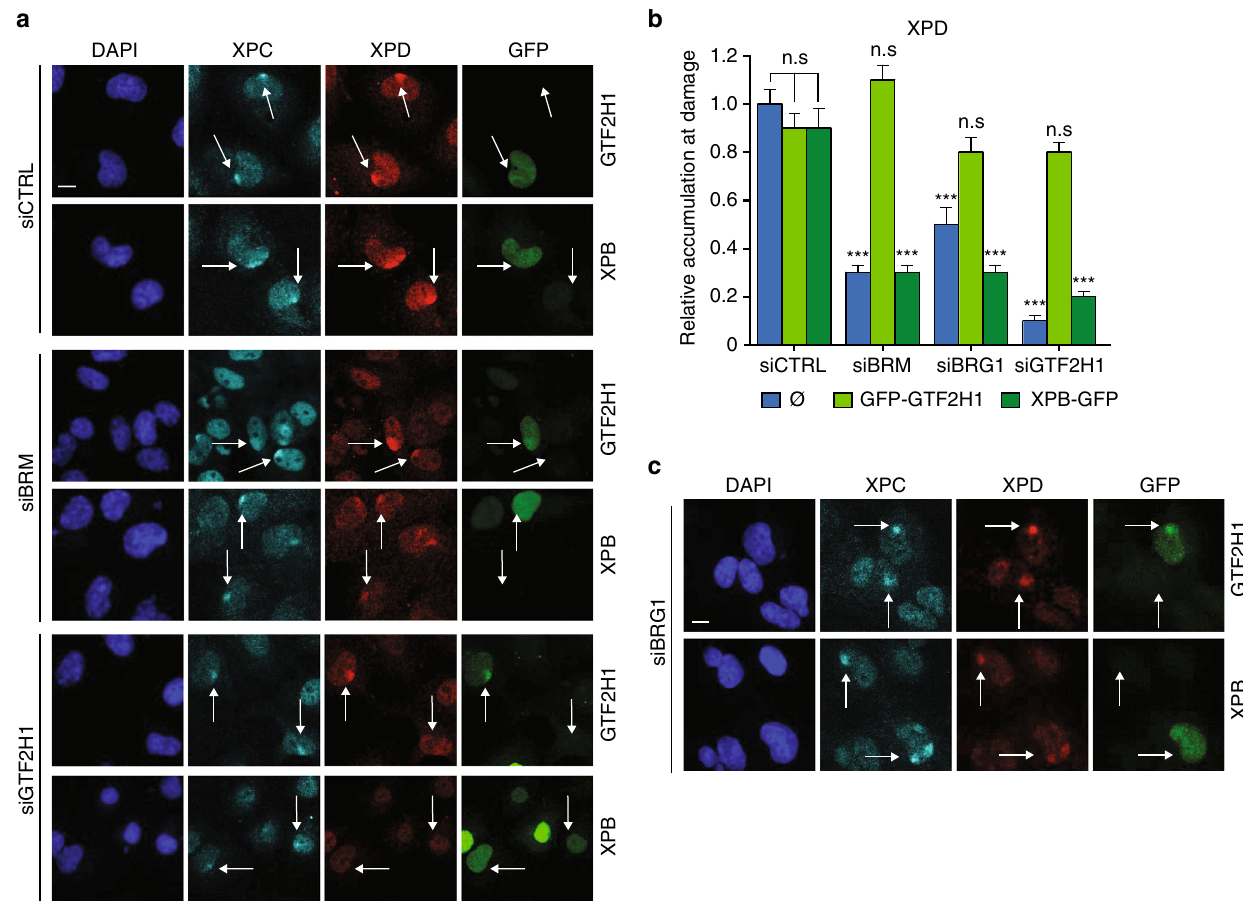
Fig. 4 GTF2H1 expression rescues TFIIH in BRM/BRG1 depleted cells. Representative IF of XPD recruitment (red channel) to LUD marked by XPC (cyan channel). U2OS cells were fi xed 30 min after local UV-C irradiation (60 J/m 2 ) through a microporous membrane (8 µ m). a U2OS cells were treated